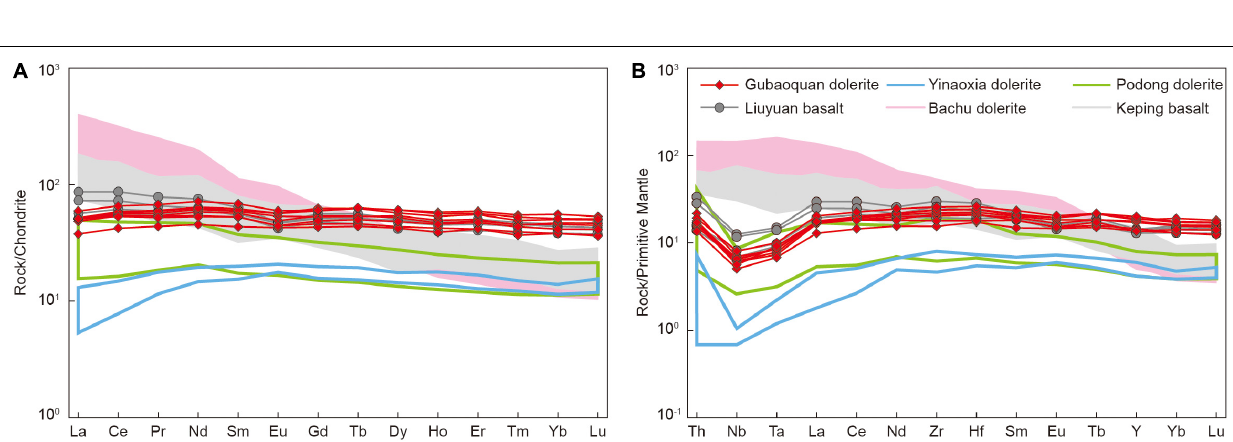
FIGURE 5 | CaSiO 3 (Wo) - MgSiO 3 (En) - FeSiO 3 (Fs) diagram showing the compositions of pyroxene (after Morimoto, 1988) from the Gubaoquan dolerite dykes.